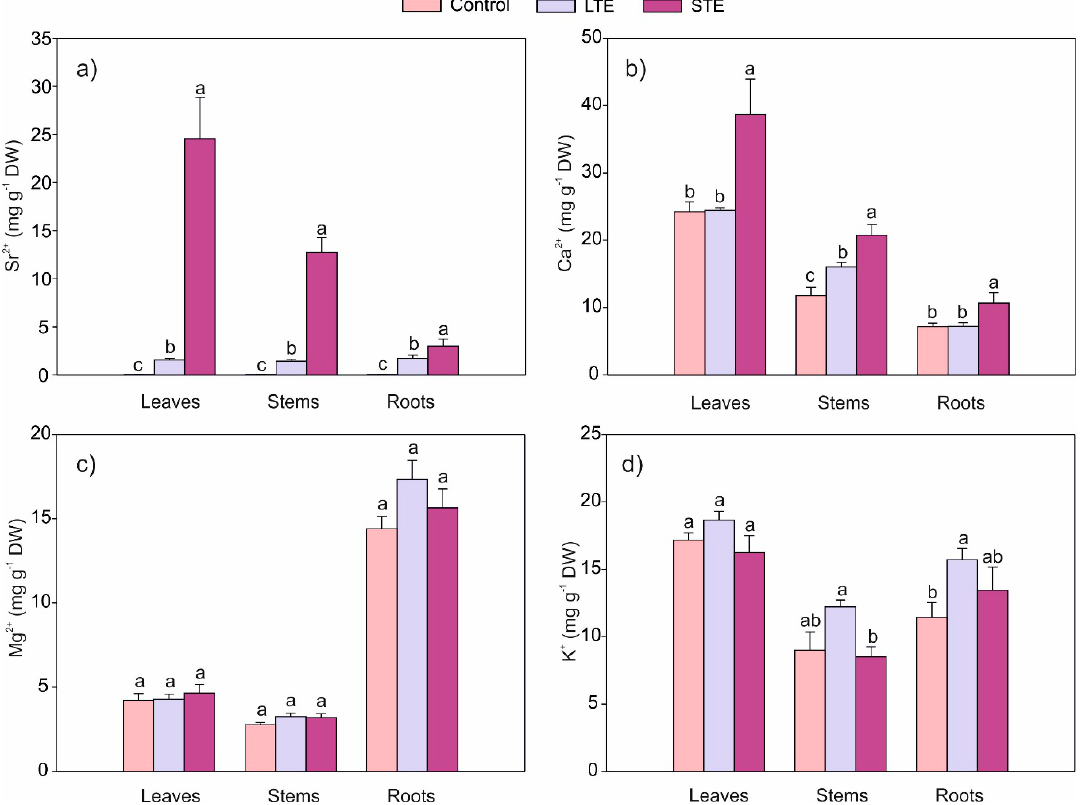
Figure 4. Content of Sr ( a ) and macroelements ( b – d ) of Glycine max with standard error (SE) (for each organ, n = 5). The data followed by the same letters within the same plants’ organs are not significantly different. Abbreviations: LTE, long-term exposure to Sr; STE, short-term exposure to Sr . Table 1. Translocation factors (TF) of Glycine max of Sr, Ca, Mg, and K for the control, long-term exposure to Sr (LTE), and short-term exposure to Sr (STE) groups ( n = 5). Data followed by the same letters are not significantly different. Abbreviations: TF L = TF leaves/roots, TF S = TF stems/roots.